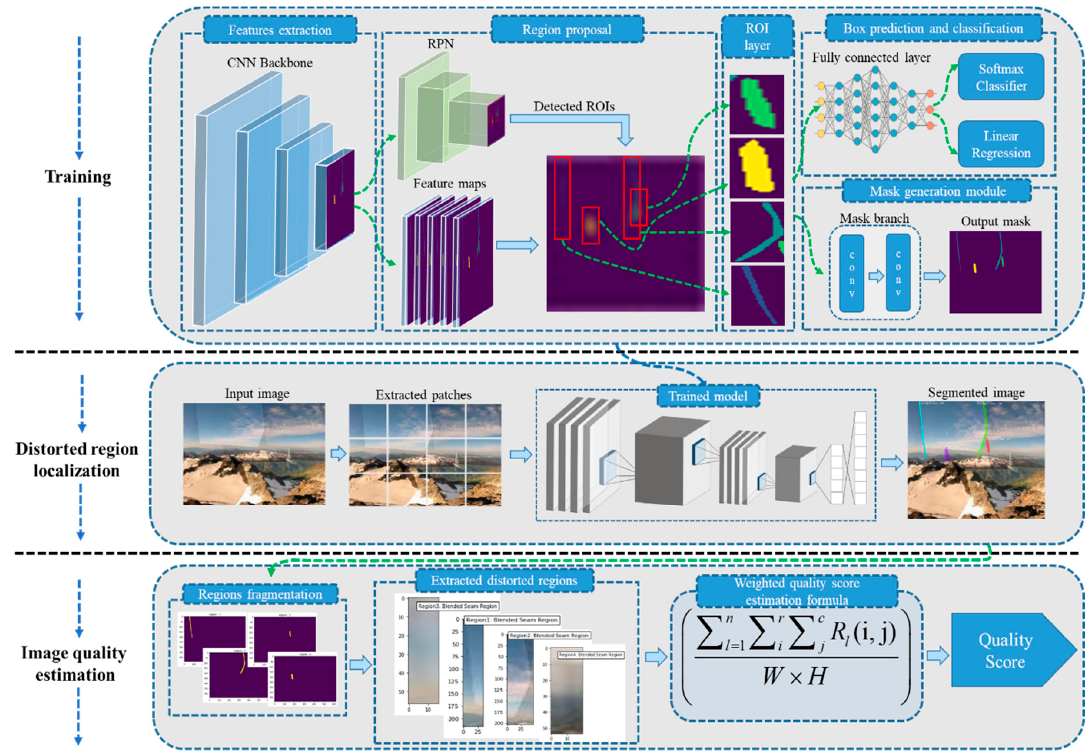
Figure 2. A detailed overview of our proposed DLNR-SIQA framework for stitching distortion localization and image quality estimation, which involves three main steps: training, distortion region localization, and image quality estimation. Step 1: The training processing procedure of the Mask R-CNN is demonstrated. Step 2 involves the segmentation of stitching distortions, where an input panoramic image is first converted into a set of patches and individual patches are forwarded to the fine-tuned Mask R-CNN. The output of the distortion region localization phase is a segmented distorted panoramic image, which is then forwarded to Step 3, where each segmented region is investigated individually and the perceptual quality is estimated by estimating the total distorted area over the total area of the panoramic image.